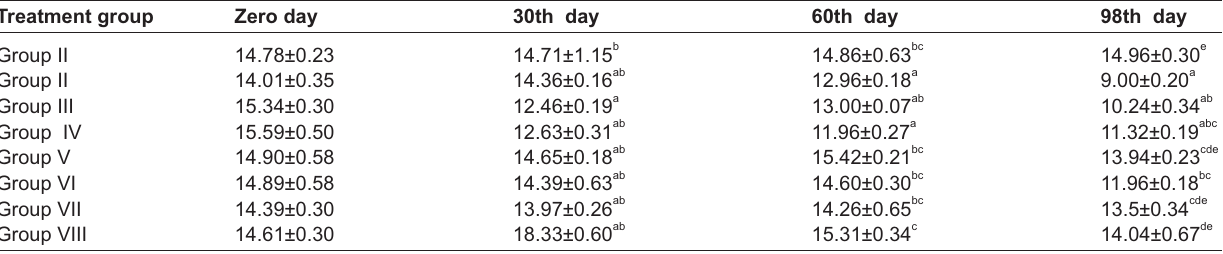
Table-5. Effect of oral administration of chlorpyriphos, lead acetate, vitamin C alone, and in combinations on blood glutglutathione peroxidase activity (U/mg protein) in rats. Treatment group